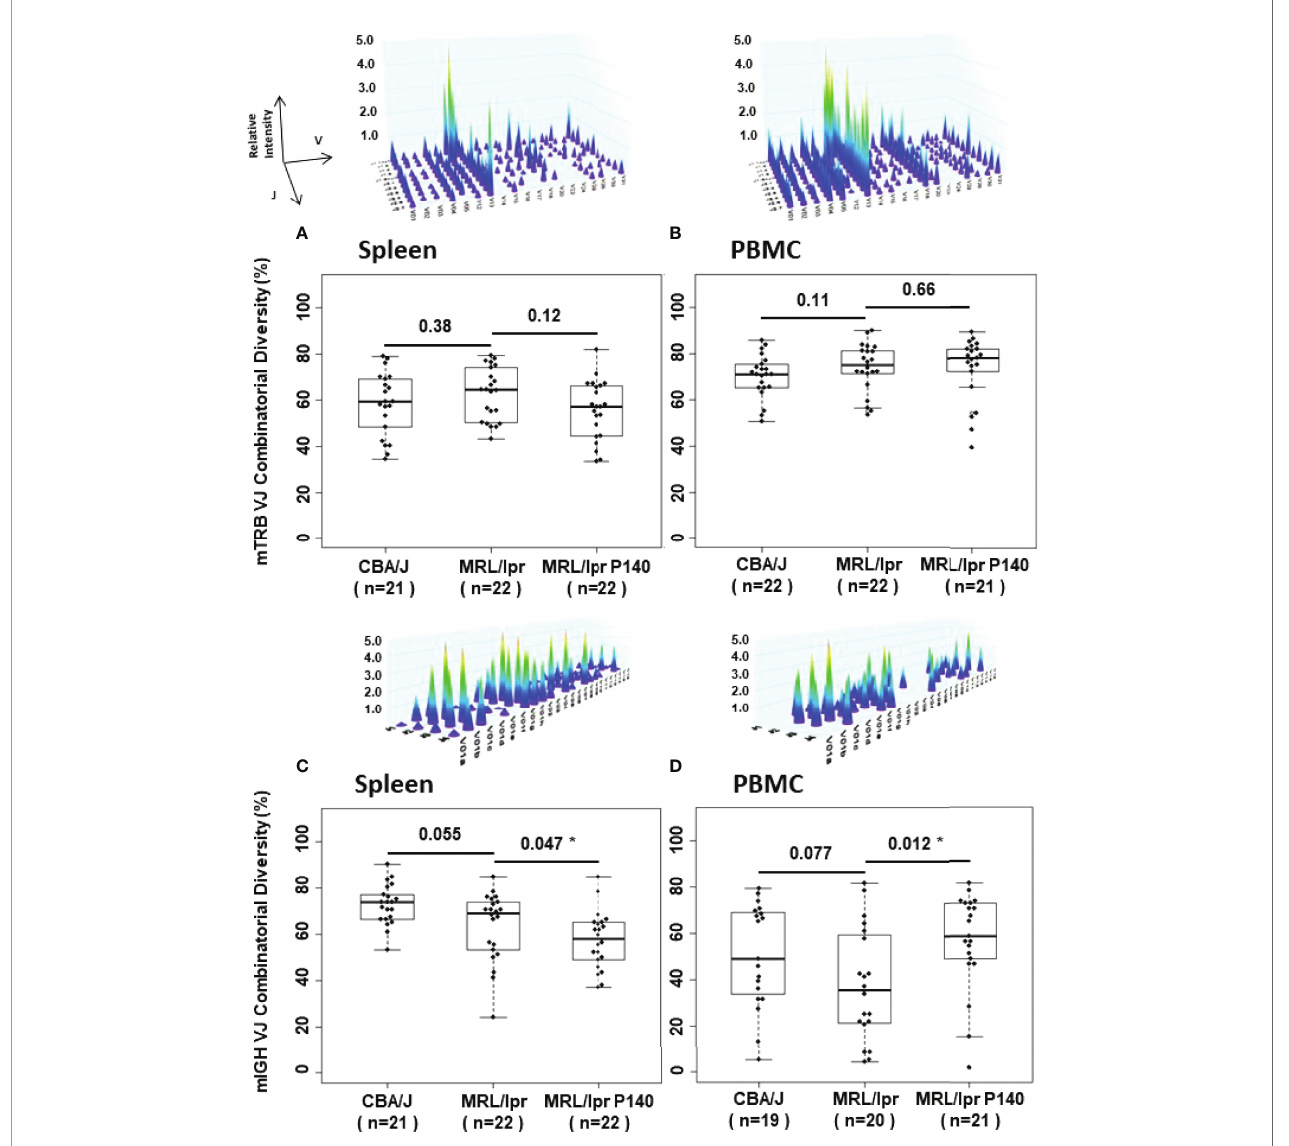
FIGURE 3 | Dot, box plot and 3-D graph representations of combinatorial mTRB and mIGH diversity distribution in spleen and PBMC samples from CBA/J and MRL/lpr mice. The 4 representative images illustrate 3-D graph of the TRB and IGH immune repertoires generated by Constel ID software (ImmunID). Each peak represents the rearrangement of a VH (or VB) gene family relative to the rearrangement of JH (or JB) genes. Relative intensity of these rearrangements is represented on the z-axis. Graphs have been generated for each dot in (A – D) . Combinatorial diversity (%) median into box plots are represented by the central line. n = number of samples examined. Comparison of diversity by Wilcoxon Rank Sum tests between two groups is indicated. *p <